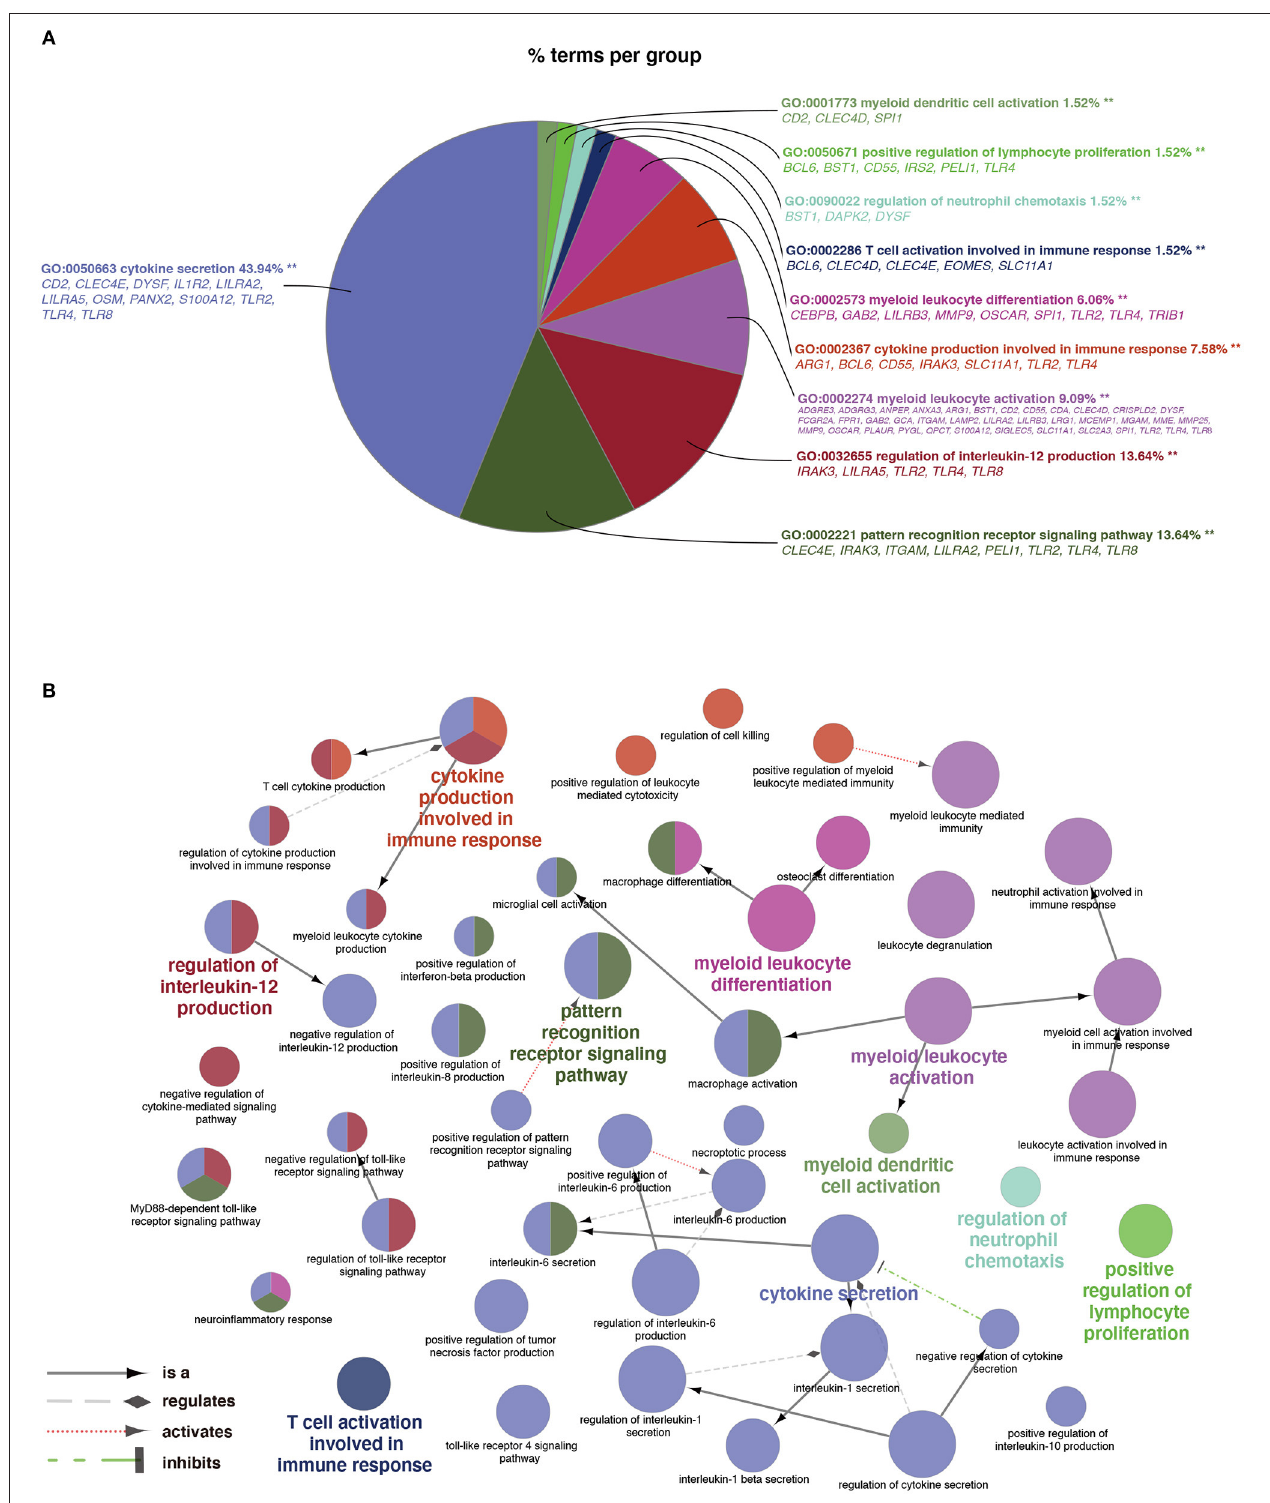
FIGURE 3 | Terms of biological process (BP) by GO analysis. (A) Representative functional BP groups selected by the hypergeometric test and the percentage of terms per group. (B) The ontology relations of the annotated terms. A p < 0.05 was considered statistically significant.